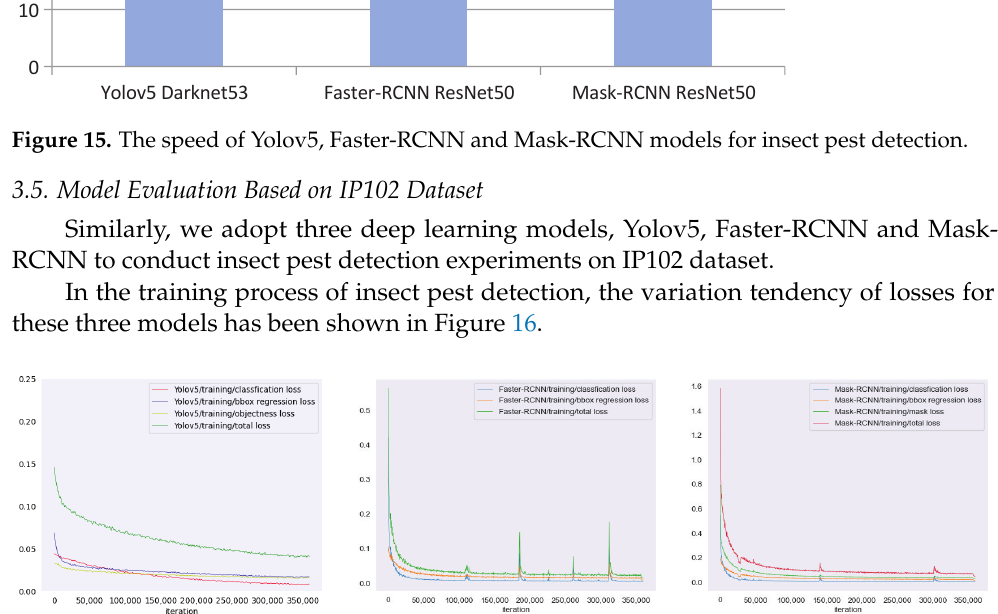
Figure 16. The loss tendency of Yolov5, Faster-RCNN and Mask-RCNN models for insect pest detection.